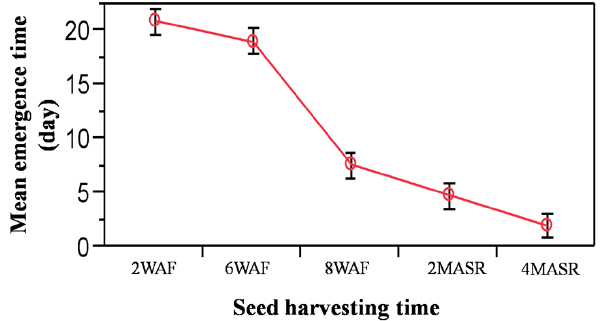
Fig. 1. Effect of different seed harvesting times on mean seedling emergence percentage of R. turcomanicus Czerep.